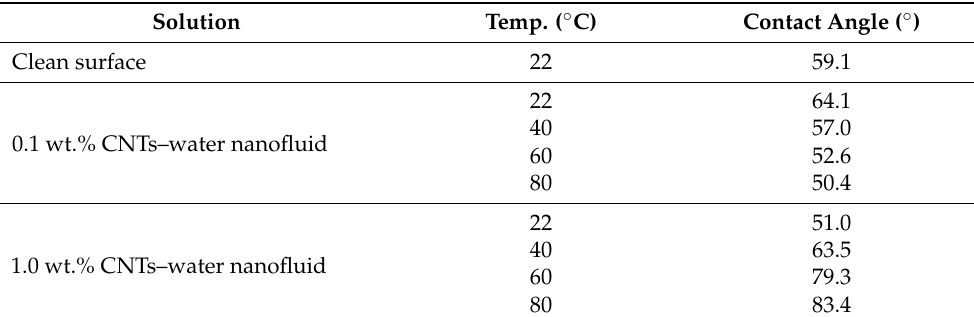
Table 7. Contact angle values for the surface of 316L stainless steel samples after corrosion testing in 0.1 and 1.0 wt.% CNTs nanofluids at different temperatures. Temp. ( ◦